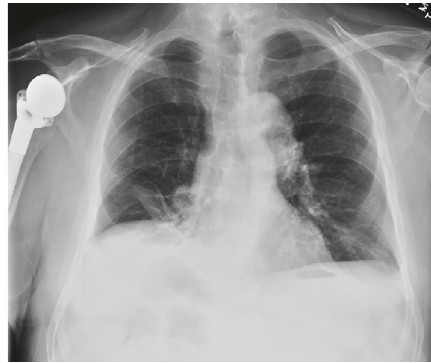
Figure 1: Chest X-ray 6 weeks postoperatively.